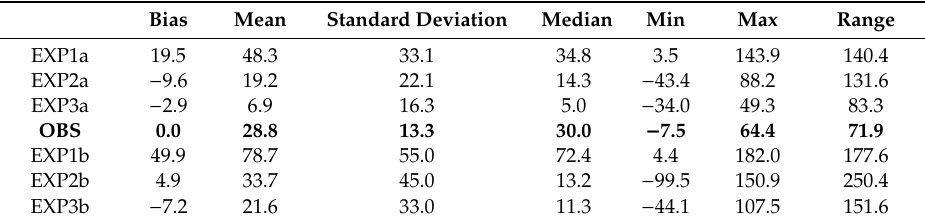
Table 7. SHF (W m − 2 ) simulated and observed at the FB station (data number 323).